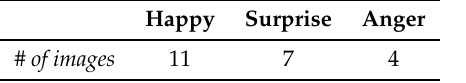
Table 3. Number of misclassified images of neutral faces in the three wrong categories over a total of 221 images.